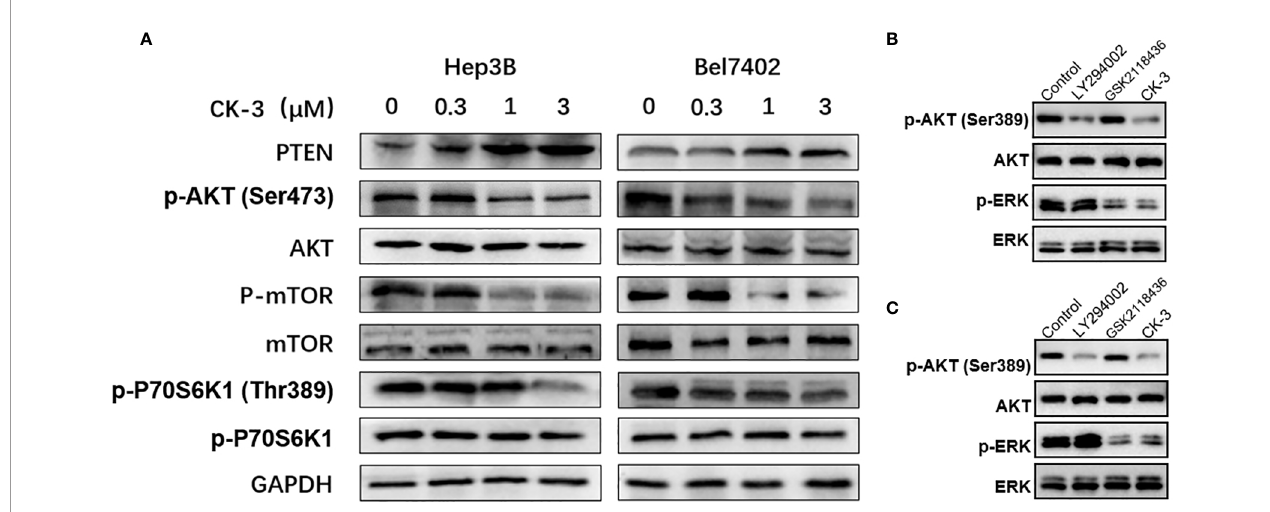
FIGURE 3 | CK-3 suppressed the PI3K/AKT/mTOR and MAPK/ERK pathways in Hep3B and Bel7402 cells. (A) Inhibitory effects of CK-3 on the level of PTEN, p-AKT, AKT, p-mTOR, mTOR, p-p70S6K and p70S6K proteins as shown with western blotting. (B, C) The inhibitory effects of CK-3, LY294002 or GSK2118436 on the level of p-ERK and EKK proteins as shown with western